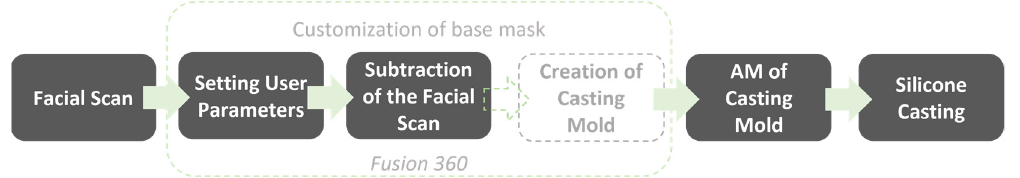
Figure 3. Final user workflow. Automatic steps are indicated by dotted lines.